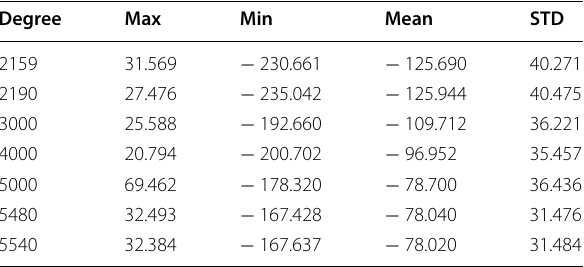
Table 7 The statistics of the differences between the gravity anomaly derived from XGM2019e with different truncated degrees and the measured data in plateau area without terrain